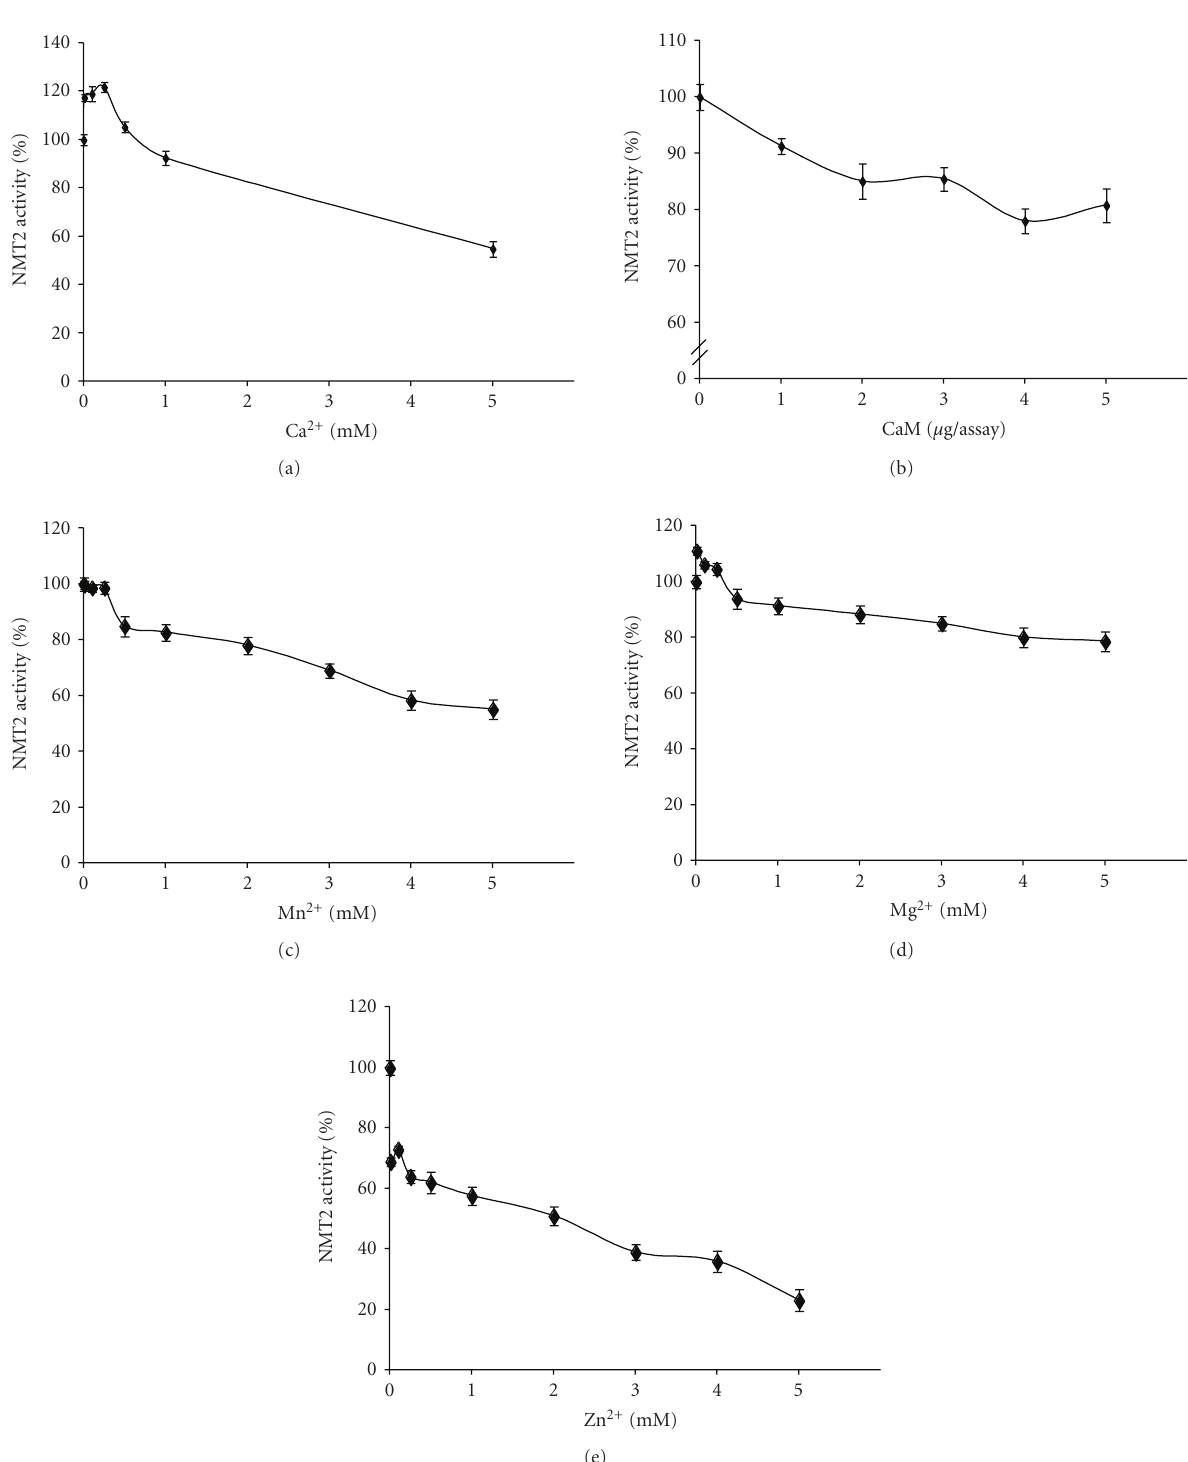
Figure 4: E ff ect of metal ions on bovine brain NMT2 activity. Bovine brain NMT2 (1.0 μ g/assay) activity was determined in the presence of carrying concentrations of (a) Ca 2+ , (b) CaM, (c) Mn 2+ , (d) Mg 2+ , and (e) Zn 2+ using cAMP-dependent protein kinase derived peptide substrate (1.0 mM). The reactions were initiated by the addition of 0.27 μ M[ 3 H] myristoyl CoA and incubated at 30 ◦ C for 30 minutes. The data presented are representative of at least three separate